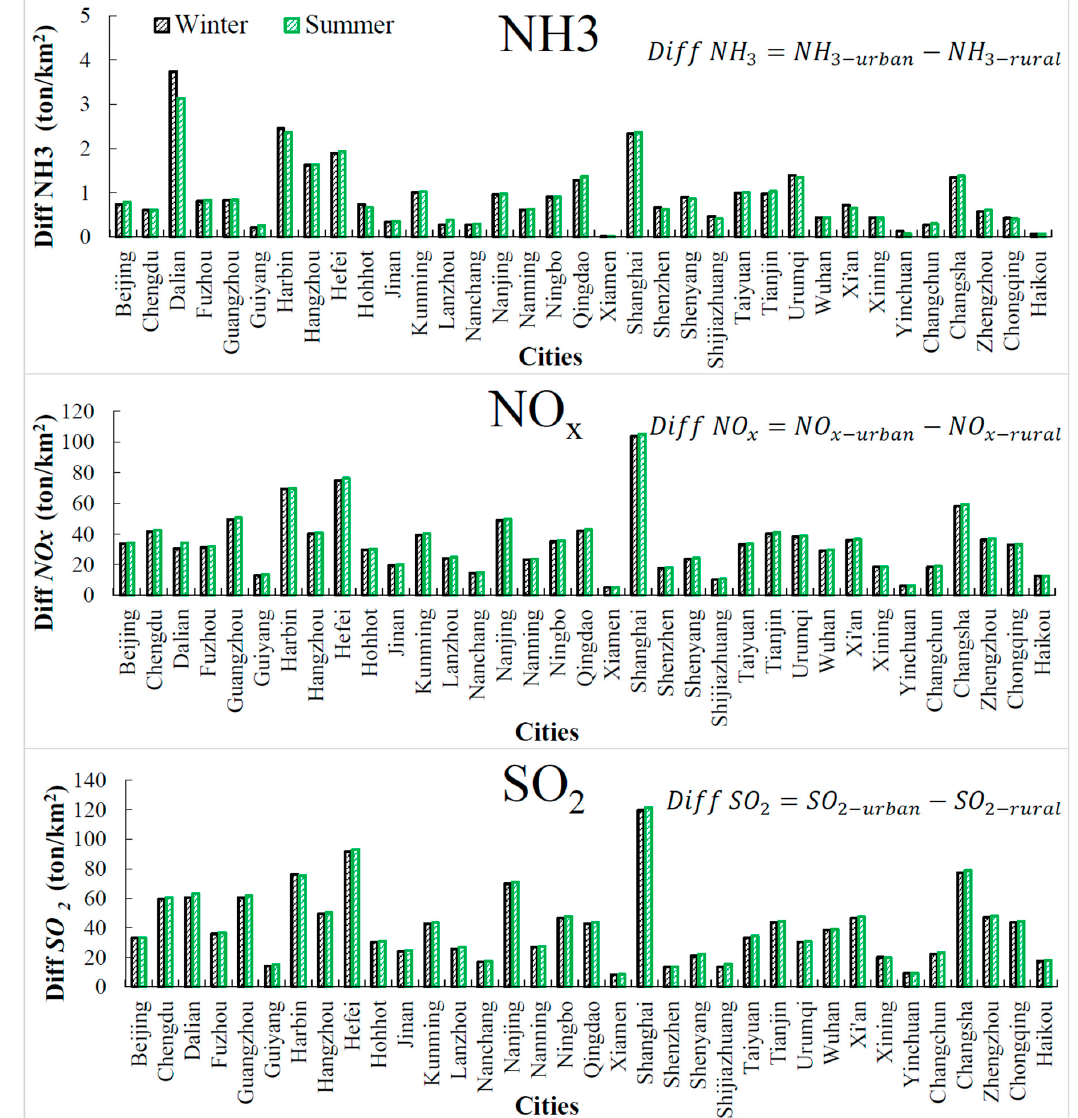
Figure 9. Wintertime (in black) and summertime (in green) NH 3 , NO x , and SO 2 emission differences (unit: ton / km 2 ) between the urban and rural areas of each city. Data are from 2010 to 2014.